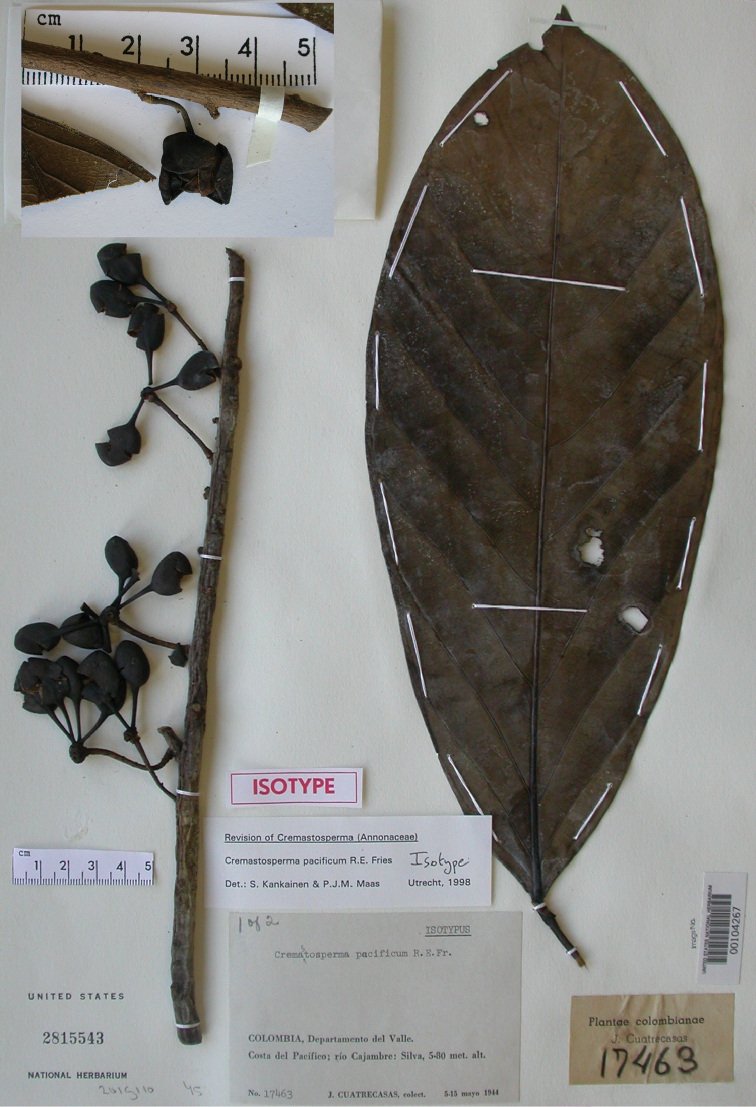
Cremastospermapacificum R.E.Fr. a fruiting specimen b flower (aCuatrecasas 17463bSánchez et al. 323).